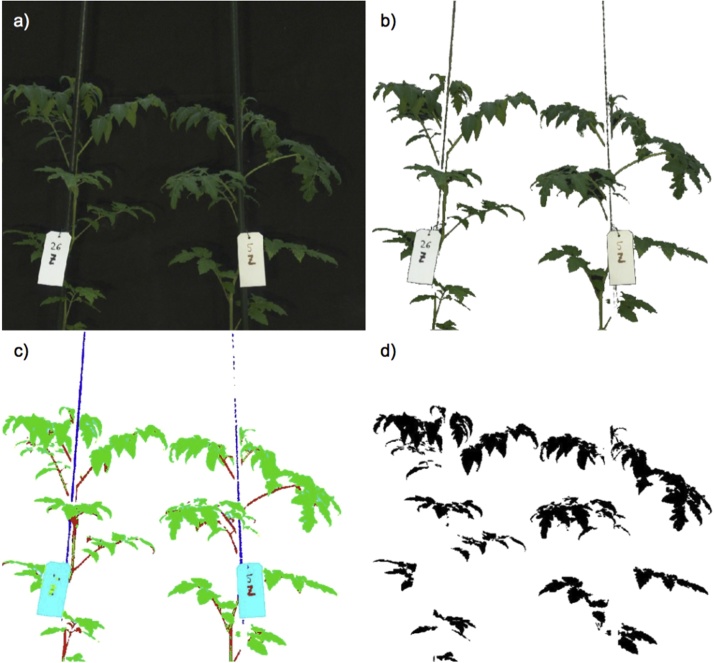
Extraction of leaf-area pixels: a) original hyperspectral image; b) background removal; c) supervised classification using spectral information divergence; and d) final mask used to extract leaf-area pixels.